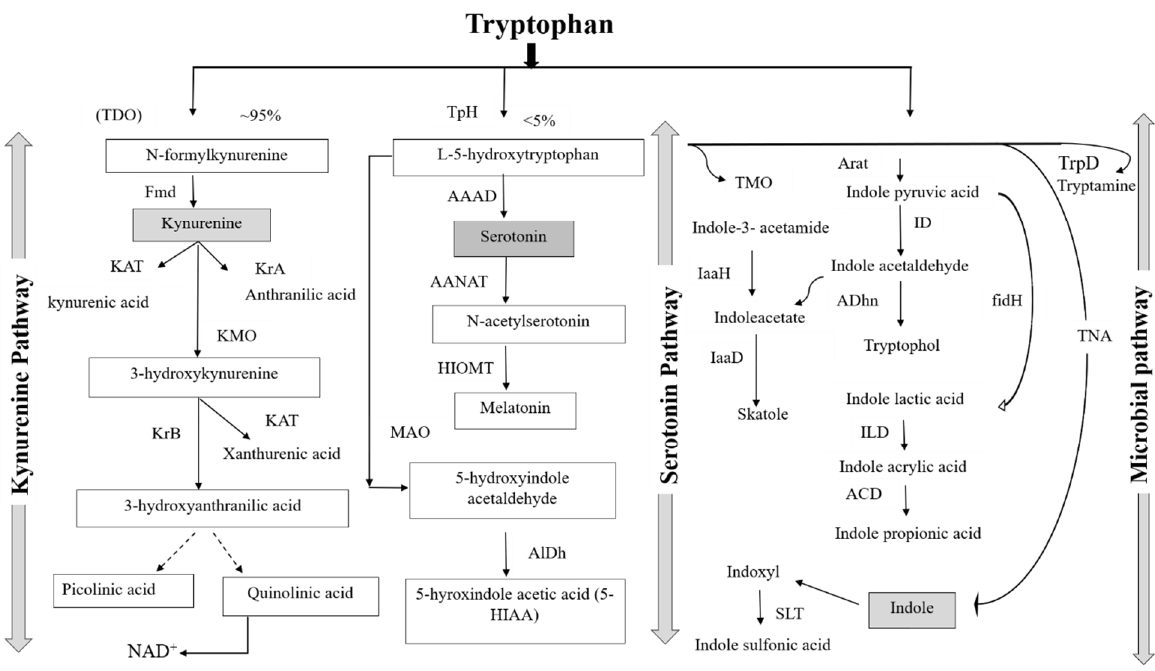
Figure 1. Three Integrated pathways of tryptophan metabolism. Tryptophan (Trp) is an essential amino acid obtained from dietary protein. The majority of Trp is metabolized alongside the kynure- nine pathway to produce different molecules collectively referred to as kynurenines. The most widely studied fate of Trp is the downstream conversion to serotonin and melatonin. Trp availability is also altered by gut microbes generating either indole or its derivatives, tryptamine or serotonin, which can affect the gastrointestinal tract. TDO, tryptophan 2,3-dioxygenase; IDO, indoleamine 2,3-dioxygenase; Fmd, formamidase; KAT, kynurenine aminotransferase; KrA, kynureninase A; KMO, kynurenine hydroxylase (monooxygenase); KrB, kynureninase B; NAD, nicotinamide adenine dinucleotides; TpH, tryptophan hydroxylase; AAAD, aromatic amine acid decarboxylase; AANAT, arylakylamine-N-acetyltransferase; HIOMT, hydroxyindolo-O-methyltransferase; MAO, monoamine oxidase; AlDh, aldehyde dehydrogenase; TrpD, tryptophan decarboxylase; TNA, tryptophanase; SLT, sulfotransferase; TMO, tryptophan monooxygenase; IaaH, indoleacetamide hydrolase; IaaD, indoleacetate decarboxylase; Arat, aromatic amino acid aminotransferase; ID, indolepyruvate de- carboxylase; ADhn, alcohol dehydrogenase; fldH, phenyllactate dehydrogenase; ILD, indolelactate dehydratase; ACD, acyl-CoA